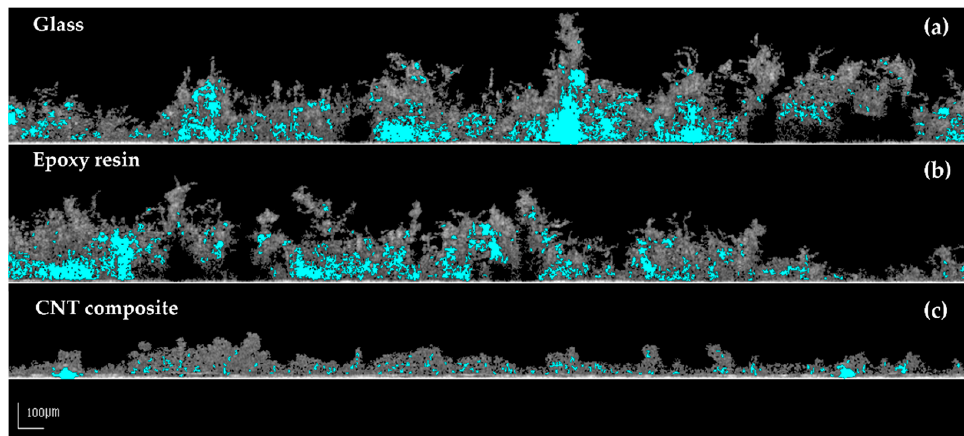
Figure 4. Representative 2D cross-sectional OCT images of Nodosilinea cf. nodulosa LEGE 10377 biofilms developed on glass ( a ), epoxy resin ( b ), and CNT composite ( c ) after 49 days. The empty spaces in the biofilm structure are filled in blue (scale bar = 100 μ m).